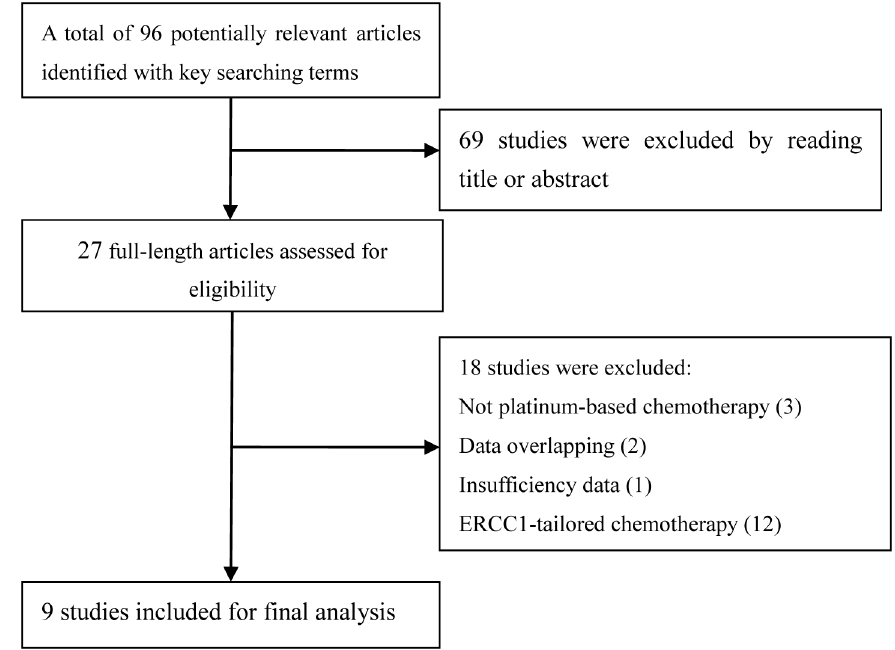
Figure 1. Flow diagram of the literature search in this meta-analysis.